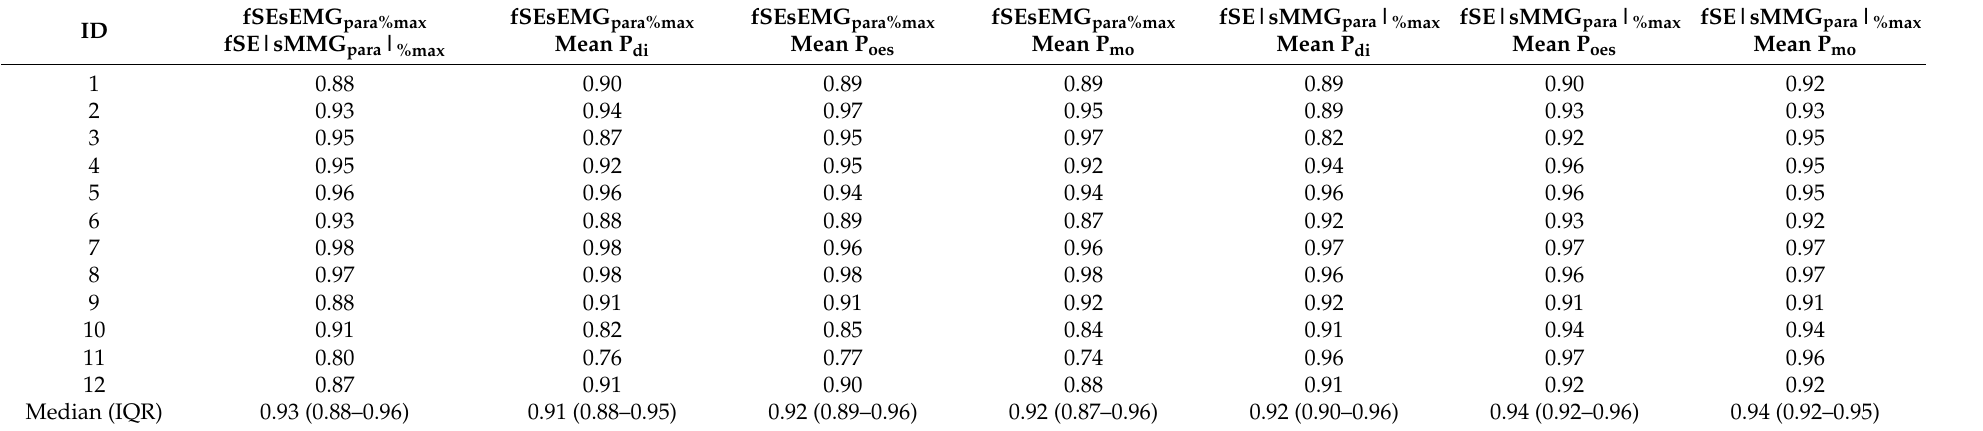
Table 1. Spearman’s ρ between measurements of respiratory pressures, fSE|sMMG para | %max , and fSEsEMG para%max .